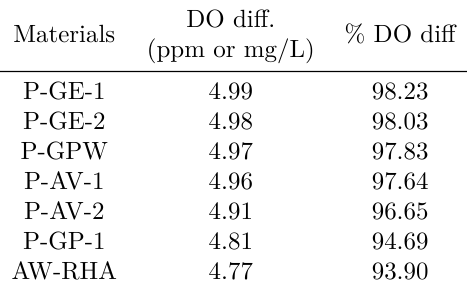
Table 5. Top percentage DO di ff erence of the can- didate